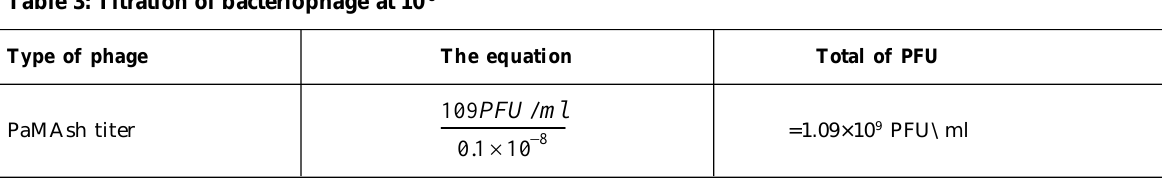
Table 3: Titration of bacteriophage at 10 -8 Type of